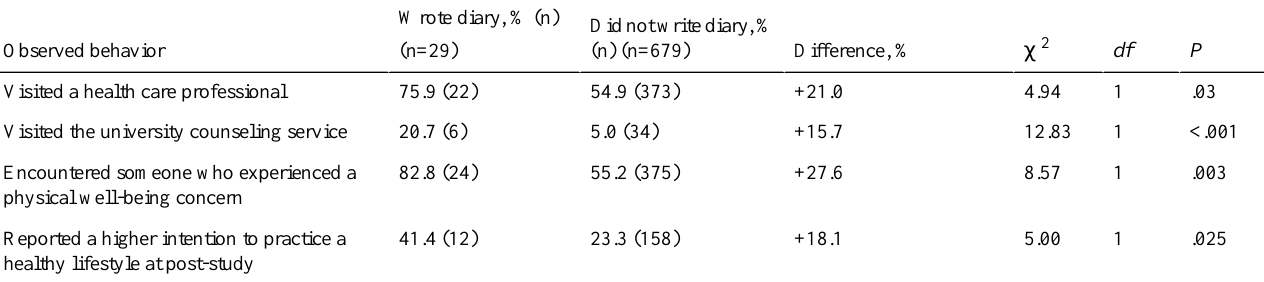
Table 7. Diary users versus nonusers.